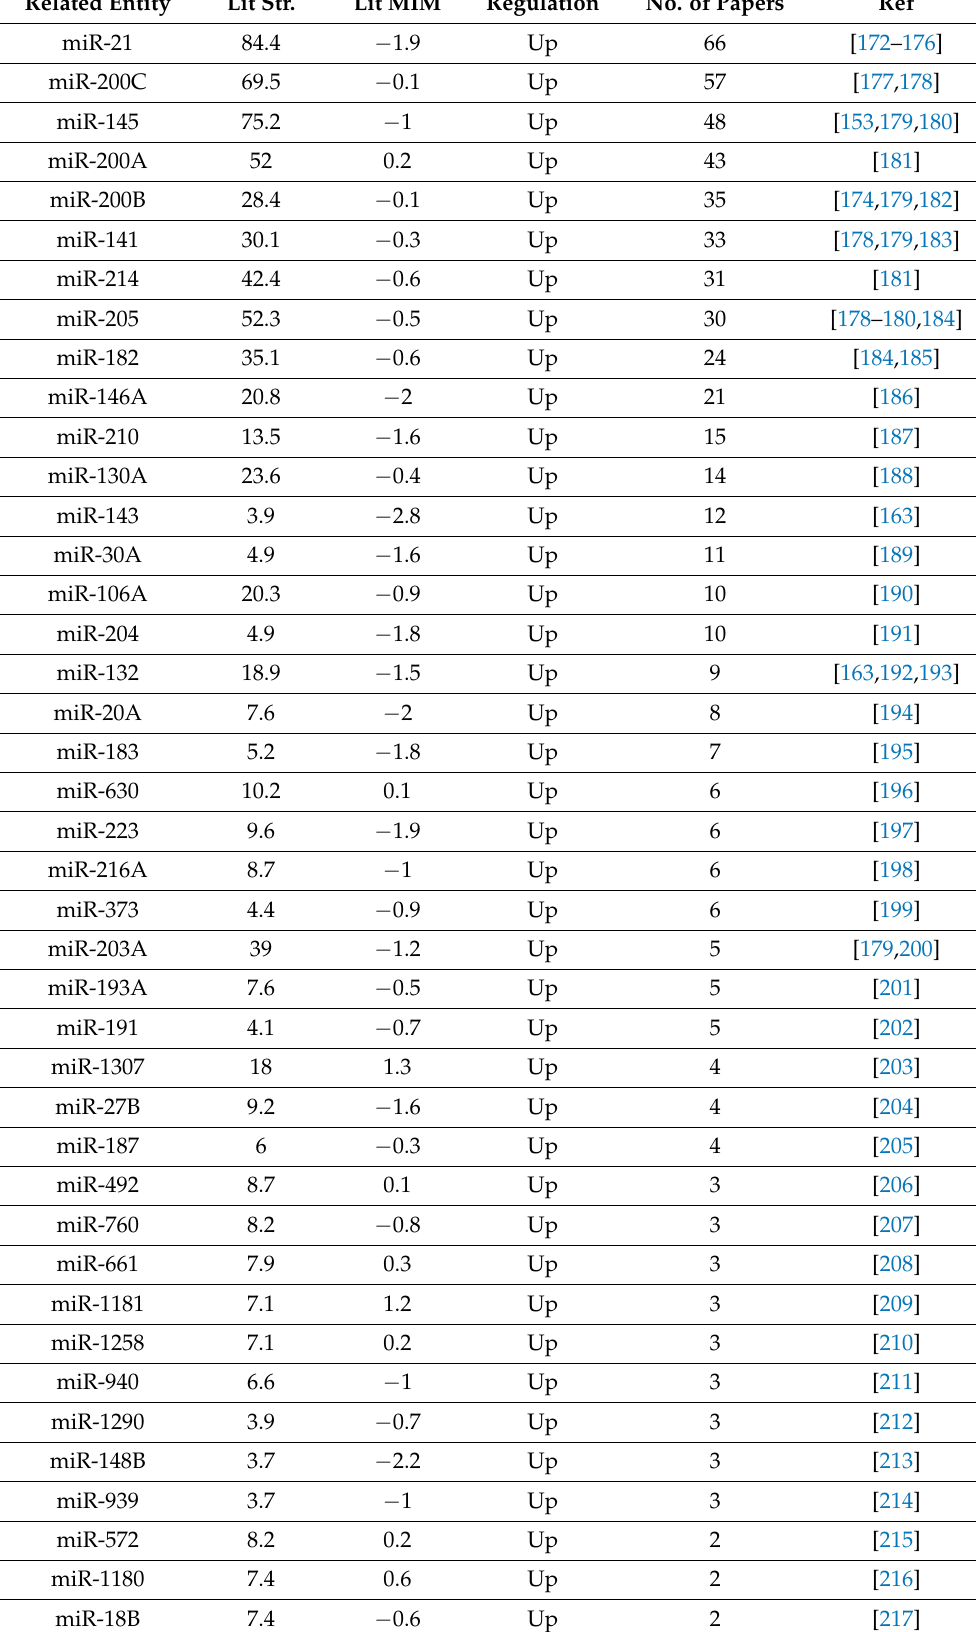
Table 1. Deregulated miR in Ovarian